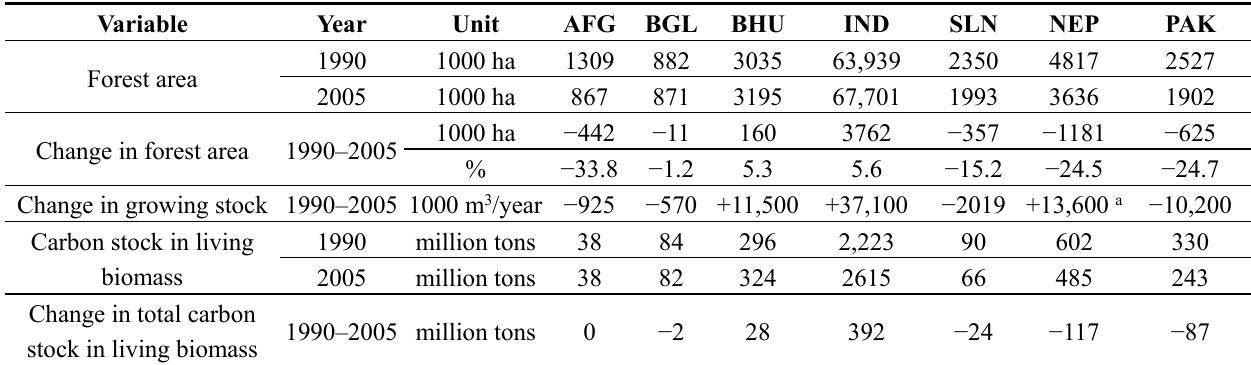
Table 1. Change in forest resources in the SAARC countries (1990–2005).